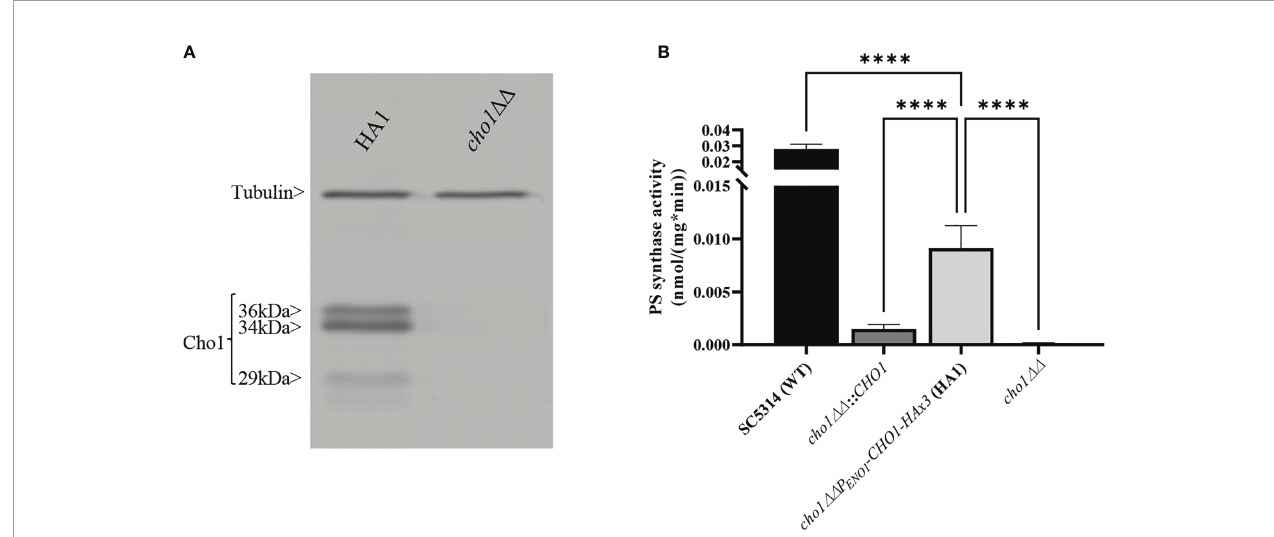
FIGURE 1 | Expression and activity of Cho1-HAx3 under the ENO1 promoter. (A) Proteins were extracted from the cho1 DD P ENO1 -CHO1-HAx3 (HA1) and cho1 ΔΔ negative control strains, separated on SDS-PAGE and blotted with anti-HA and anti-tubulin (loading control) antibodies. Three bands (36 kDa, 34 kDa and 29 kDa) are present in the HA1 strain, in addition to the tubulin loading control. (B) Total membranes were collected from wildtype strain SC5314 (WT), the CHO1 re- integrated strain where CHO1 is expressed from its native promoter ( cho1 ΔΔ ::CHO1 ), the HA1 strain, and the cho1 ΔΔ negative control strain. PS synthase activity (nmol/(mg*min)) was measured from 0.5 mg crude membrane protein for 30 min. Statistics were conducted using one-way ANOVA (****p < 0.0001). For each strain, PS synthase activity was measured in duplicate with a total of six biological replicates.